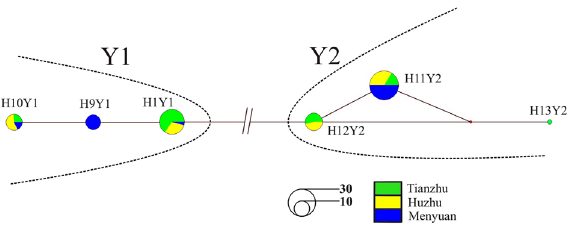
Figure 2. Median-joining network of six Y-haplotypes identified in three Chinese white yak breeds/populations based on Y-SNP and Y-STR makers. Colors correspond to different breeds/populations. The size of each haplotype circle denotes the number of observed